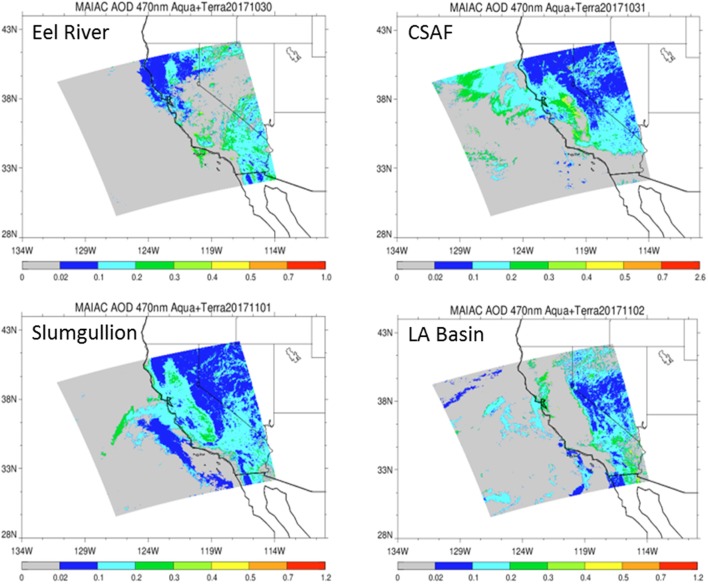
Aerosol Optical Depth (AOD) measurements at 470 nm based on the MAIAC retrieval algorithm derived from combined satellite datasets (MODIS/Terra and MODIS/Aqua) shows vertically integrated aerosols over relevant flight lines.